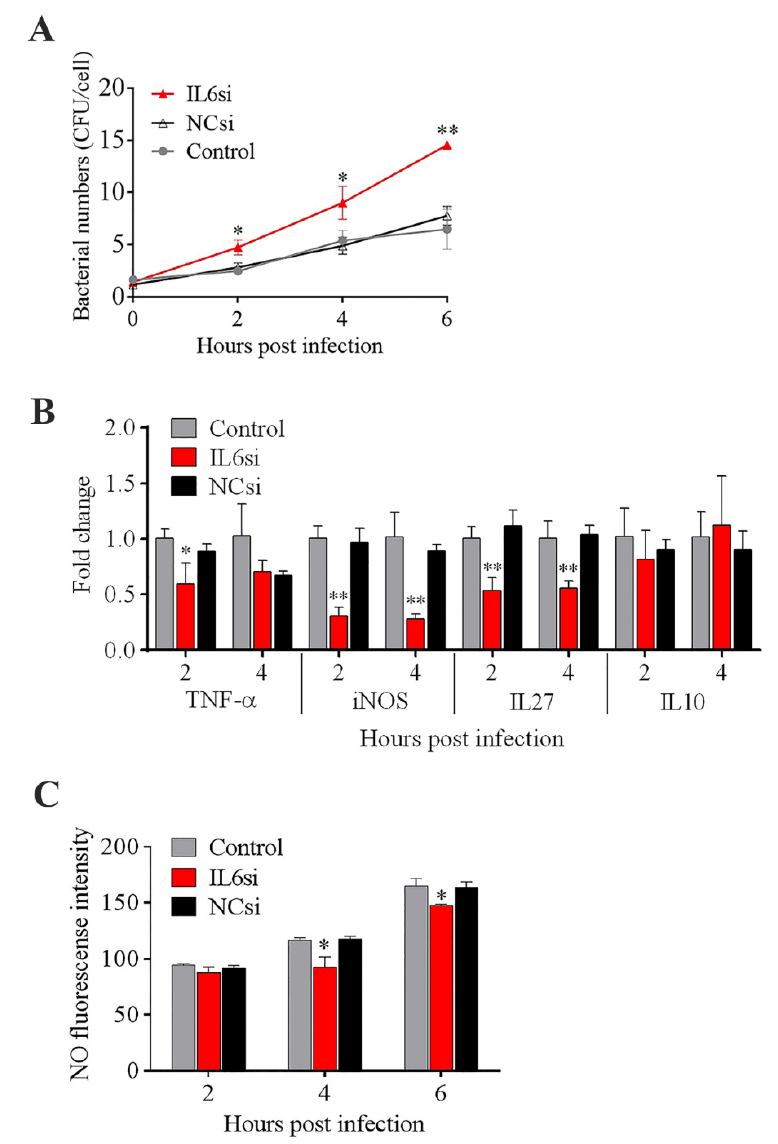
Figure 5. Effect of IL6 knockdown on Edwardsiella tarda infection and inflammatory cytokine expression. RAW264.7 cells treated with or without (control) IL6si (a siRNA targeting IL6) or NCsi (negative control siRNA) were infected with E. tarda for 1 h, and the extracellular bacteria were killed by antibiotic treatment. The cells were then incubated for different hours. After incubation, the intracellular bacterial number ( A ), the expression of inflammatory genes ( B ), and nitric oxide (NO) production ( C ) were determined. Values are the means of triplicate experiments and shown as mean ± SD. * p < 0.05; ** p < 0.01.